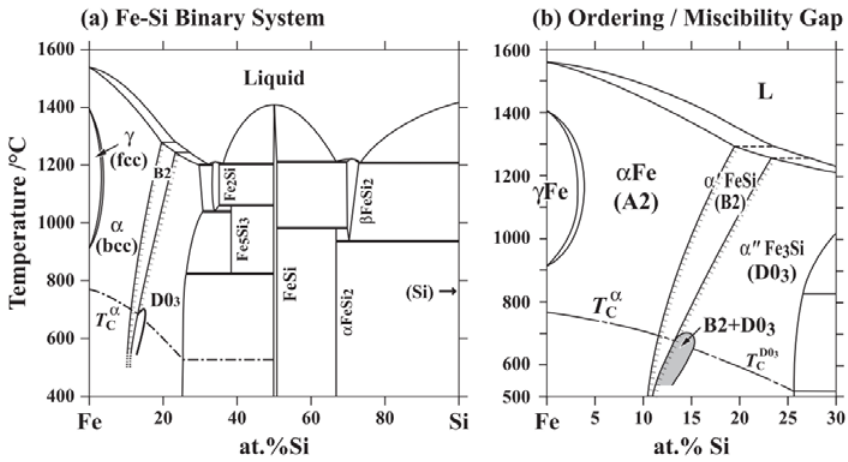
Figure 9. Phase diagrams of the Fe–Si binary system assessed by Kubaschewski from [33].